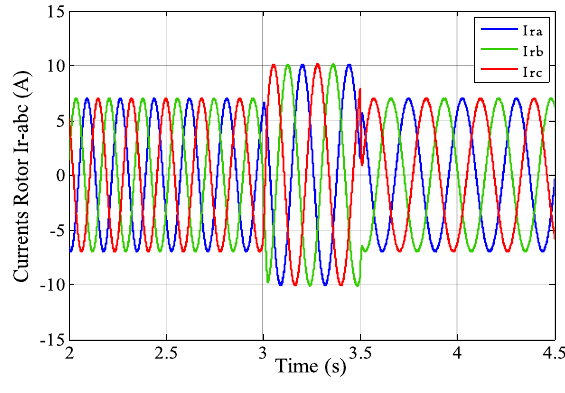
Fig. 18 Rotor Currents I r-abc (A)